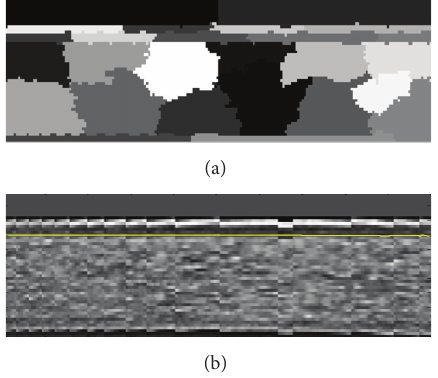
Figure 12: (a) Output of Graph Cut. (b) The estimated boundaries.